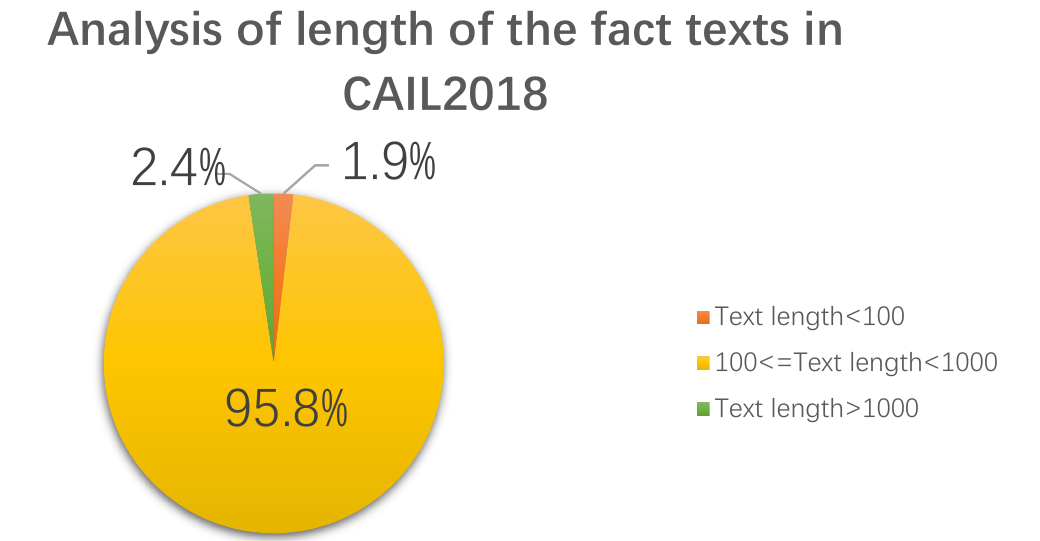
Figure 7. Fact description text length analysis in CAIL2018.